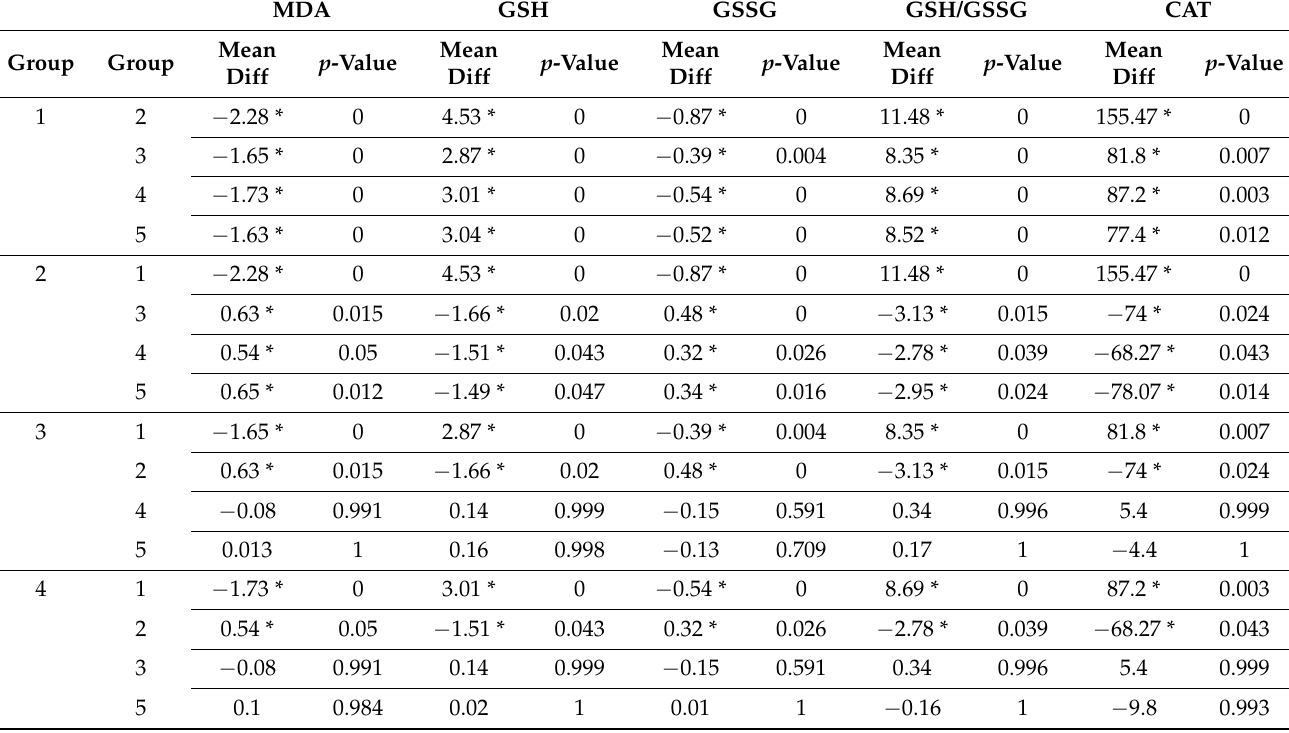
Table 2. Scheffe’s test results for multiple